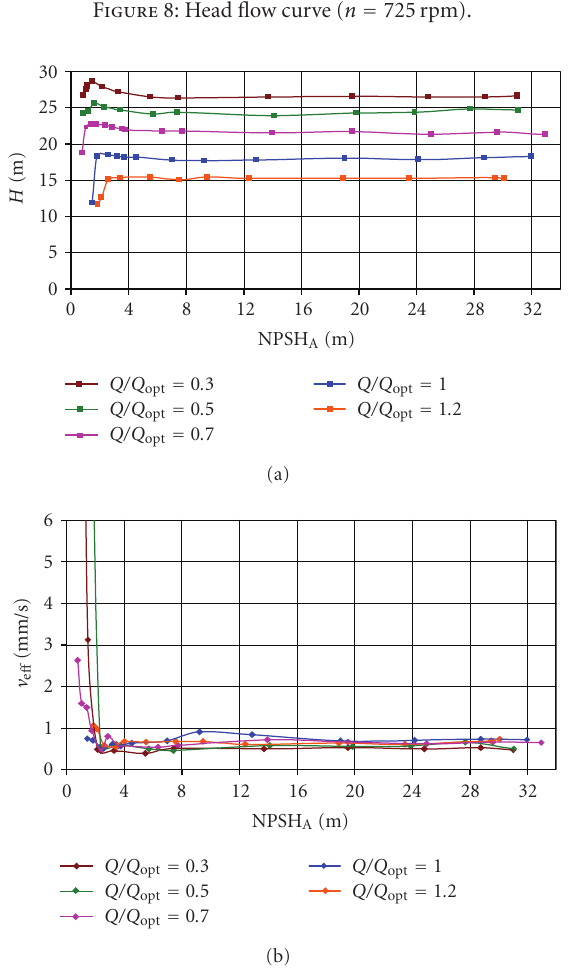
Figure 12: NPSH IC ( n =